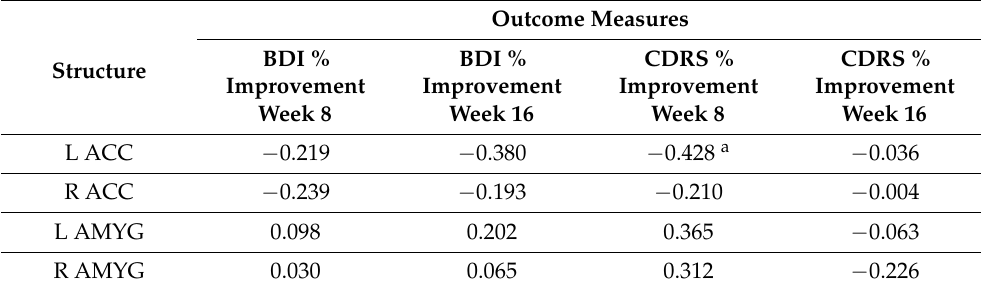
Table 2. Results (standardized Beta coefficients) of linear regression analyses modeling brain structure as a predictor of clinical